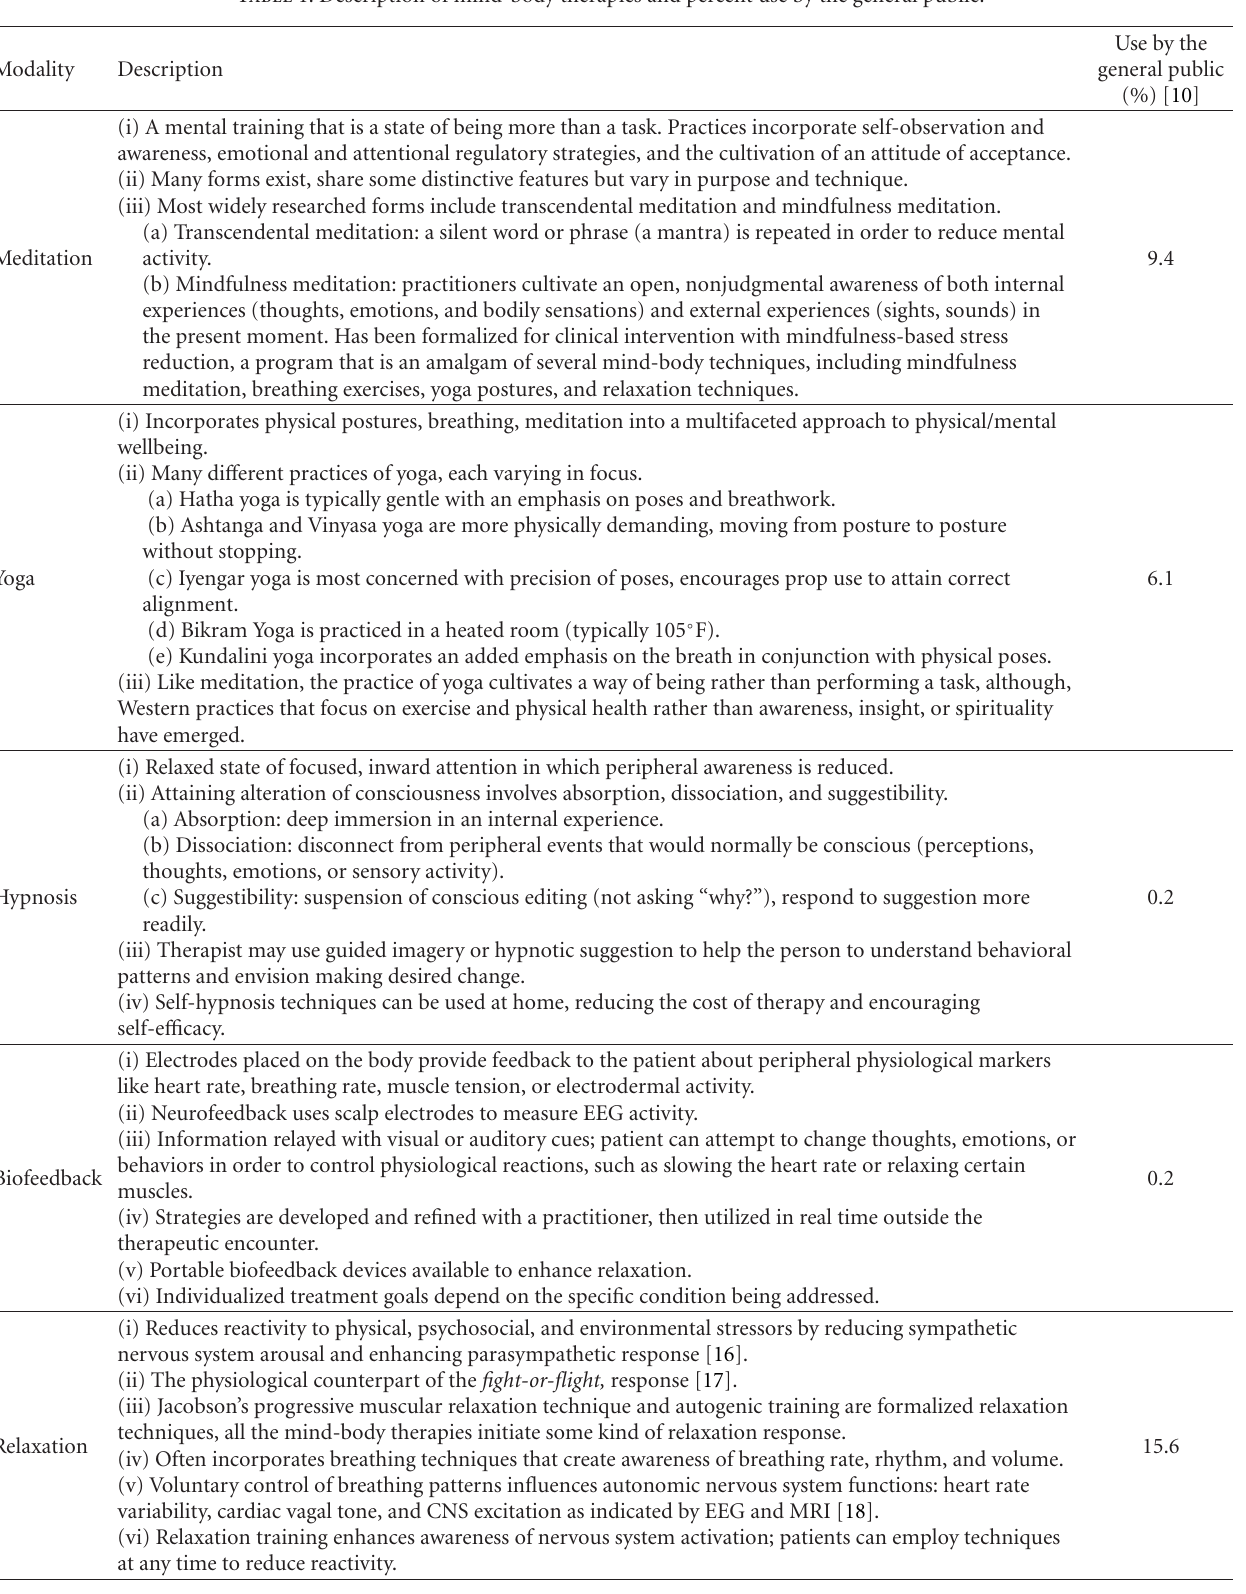
Table 1: Description of mind-body therapies and percent use by the general